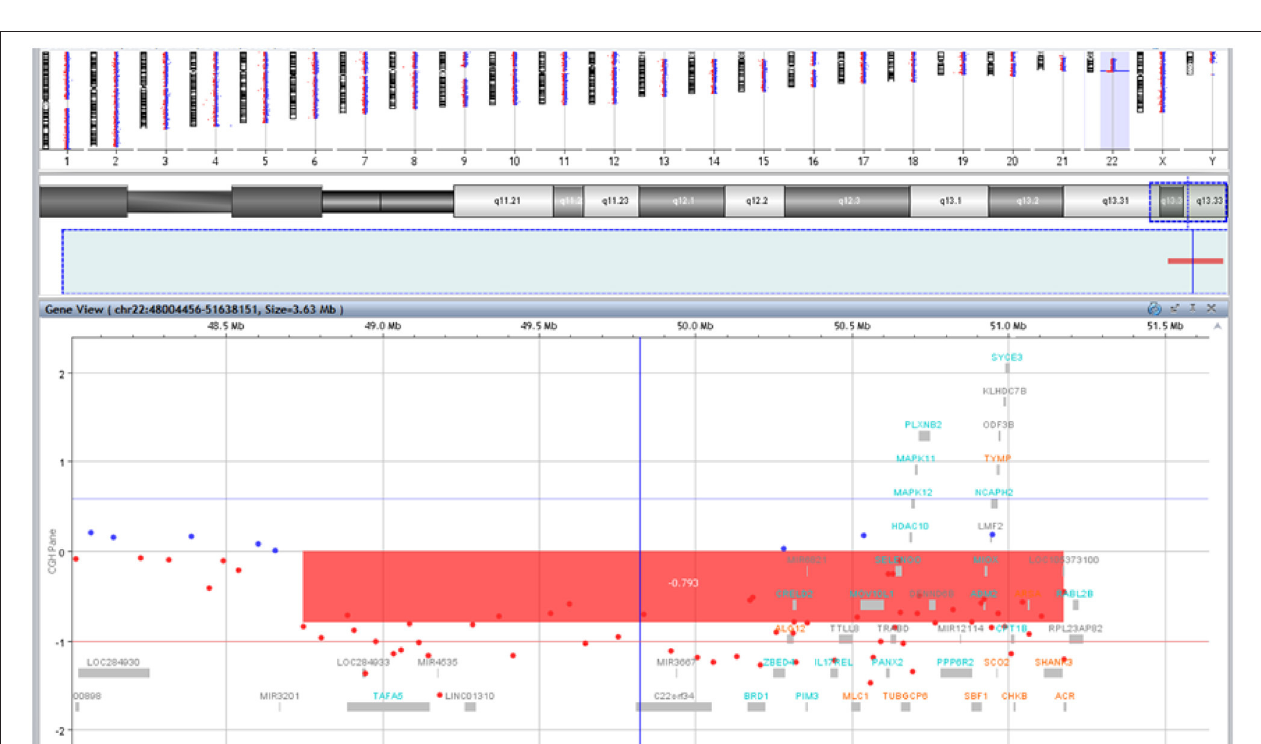
FIGURE 5 | Results of array-CGH analysis. Zoom view of long arm of chromosome 22 shows a 2,4Mb deletion at 22q13.32q13.33 spanning from position 48746241 bp to the telomere.